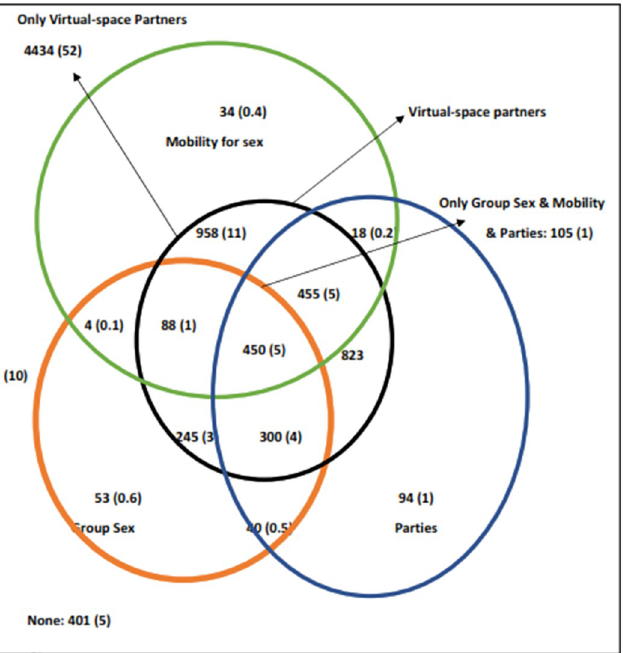
Fig 2. Venn diagram showing the distribution and overlap of various behaviours (partners from virtual space, group sex, mobility for sex, attend parties) in 8582 men who have sex with men in Mumbai, India.